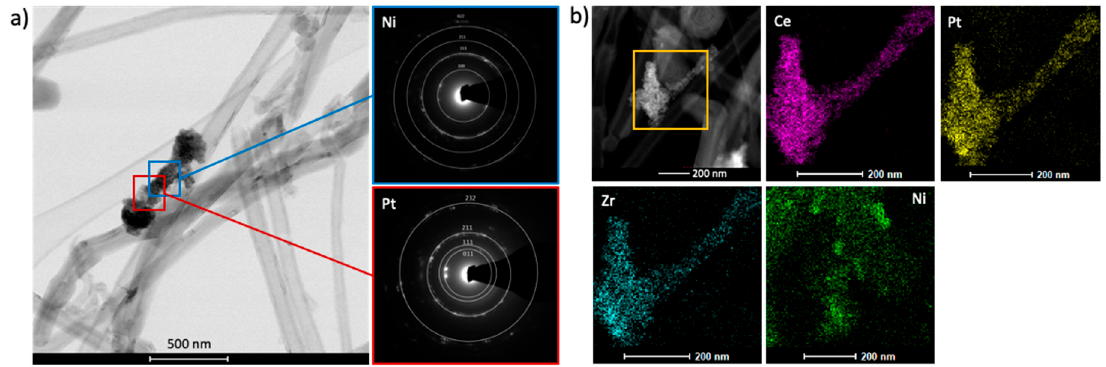
Figure 6. High-resolution TEM (HRTEM) of Pt-Ni-CZ/CFF sample. The specific surface area (SSA), total pore volume (V t ) and average pore diameter (d) of pristine carbon fibres (CF), oxidised carbon fibres (CFF) and CFF-supported catalysts are presented in Table 2. As was expected, the SSA of carbon fibres increased after their oxidation in HNO 3 (from 26 m 2 /g for CF to 100 m 2 /g for CFF). Whereas deposition of the active phases over CFF resulted in partial coverage of its surface and blockage of pores, which decreased the SSA. The most important drop of SSA was observed for the material with the highest content of the active phase, i.e., Pt-Ni-CZ/CFF, whose BET surface area was 44 m 2 /g. Table 2. Textural properties of CFF supported CeZrO 2 , Ni-CeZrO 2 , Pt-CeZrO 2 , Pt-Ni-CeZrO 2 cata- lysts.